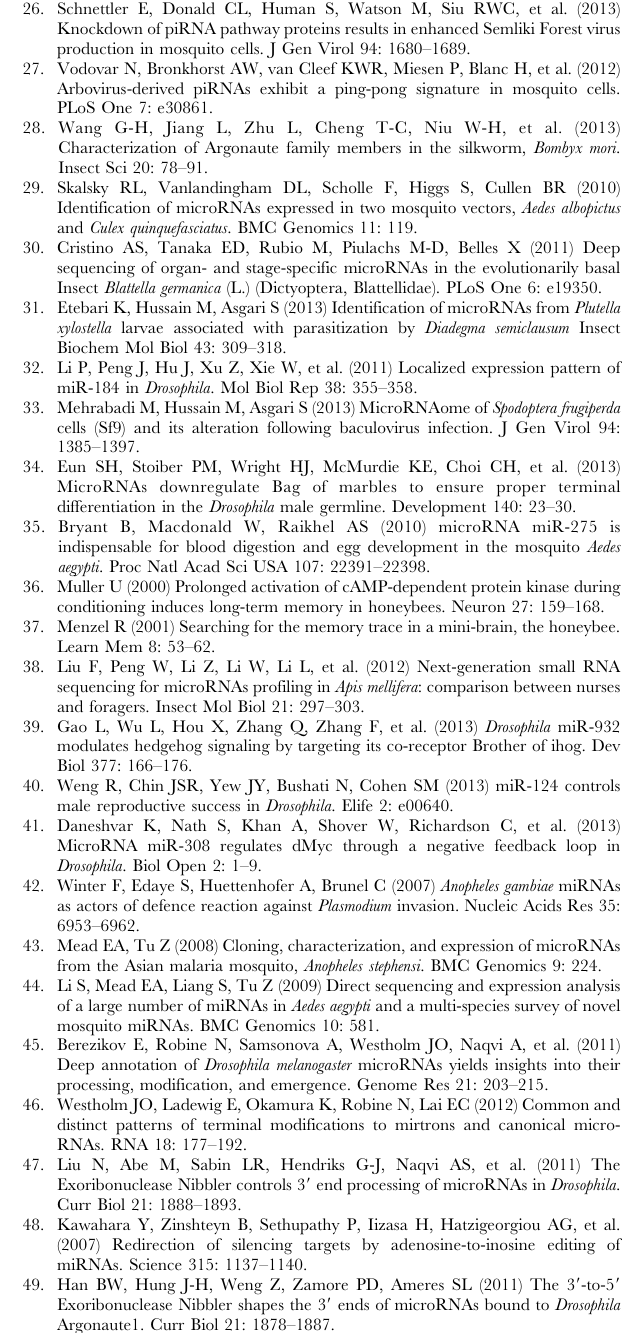
Figure S1 1% Denaturing agarose gel of RNA in the nucleus and cytoplasmic fractions from Aag2 and Pop cells. 5S specific probe to the nuclear fraction was used in Northern blot to confirm integrity and purity of the nuclear RNA.